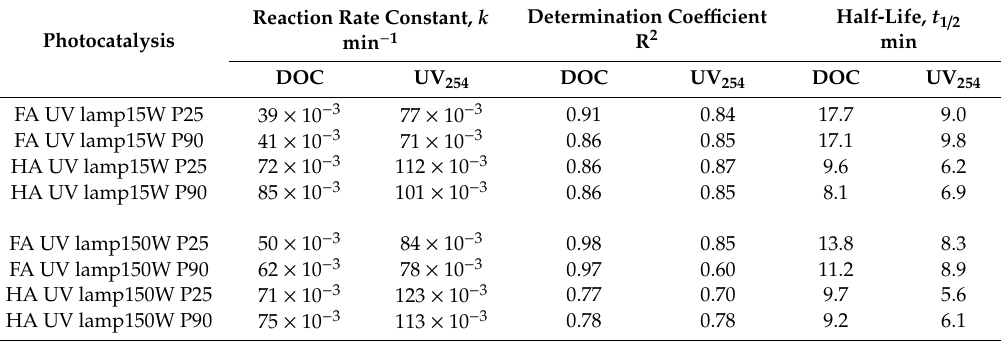
Figure 3. Pseudo-first-order kinetics of FA and HA acids removal (dose TiO 2 0.3 g/L). Table 1. Reaction rate constants and FA and HA decomposition half-lives photocatalysis.